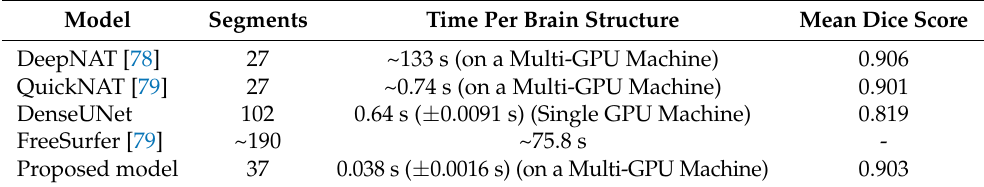
Table 3. Segmentation time per brain structure for a single MRI